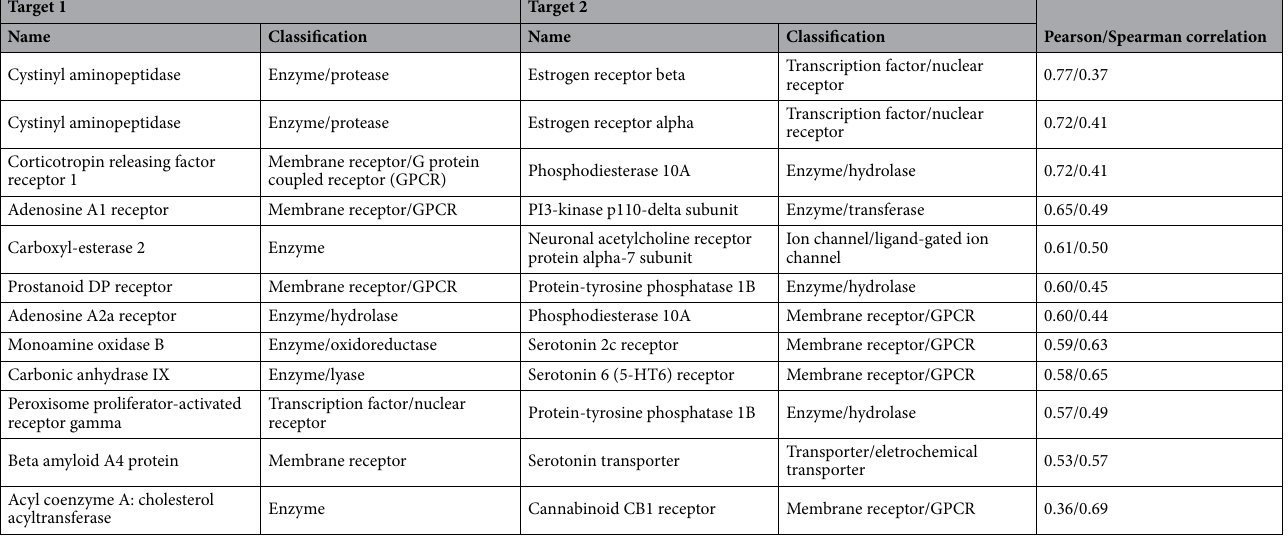
Table 2. Exemplary strongly correlated pairs of proteins from different